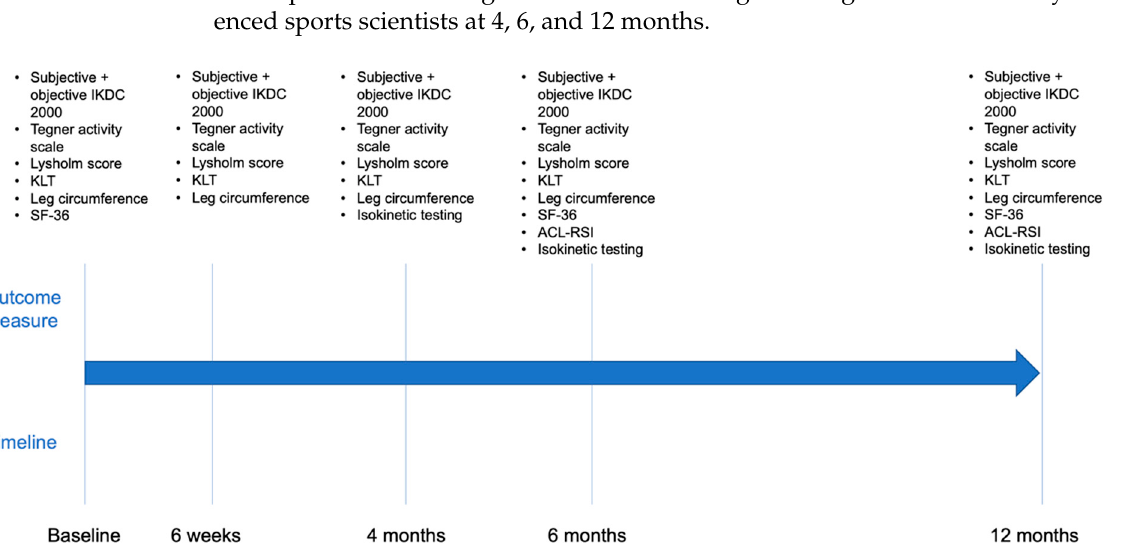
Figure 1. Timeline of follow-up examinations. ACL-RSI, Anterior Cruciate Ligament—Return to Sport after Injury. IKDC, International Knee Documentation Committee. KLT, knee laxity tester. SF- 36, Short Form 36.